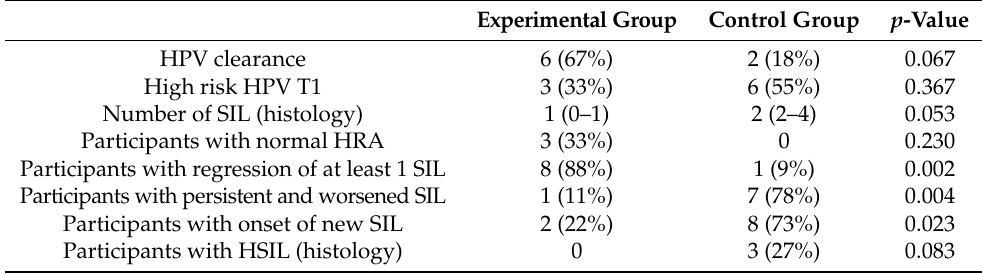
Table 2. Characteristic of the two groups at the end of the study (T1). Data are reported as total number (%) ore median